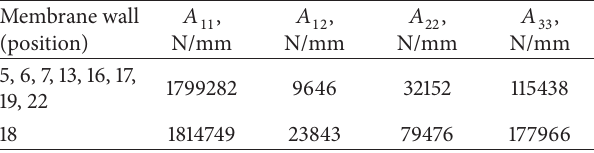
Table 4: Members of elasticity matrix of equivalent orthotropic plate for membrane walls of “Milano” boiler for membrane stiffness.